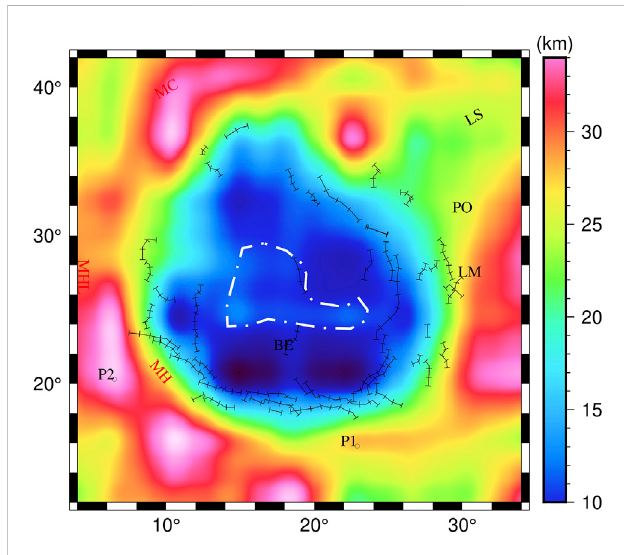
FIGURE 7 Invertedcrust-mantleinterfacedepthbeneaththeMareSerenitatis. The white dashed lines represent the inferred falling area of the crust- mantle interface uplift. P1 and P2 are the locations of lunar seismic inversion from Chenet et al. (2006).